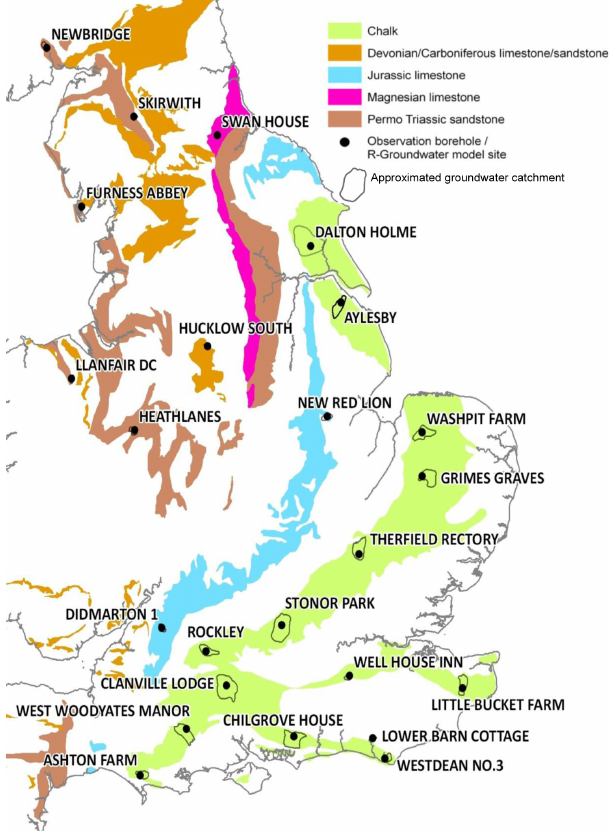
Figure 2. Future Flows Hydrology R-Groundwater model sites. © Copyright NERC (BGS) 2012. Contains Ordnance Survey data © Crown Copyright and Database